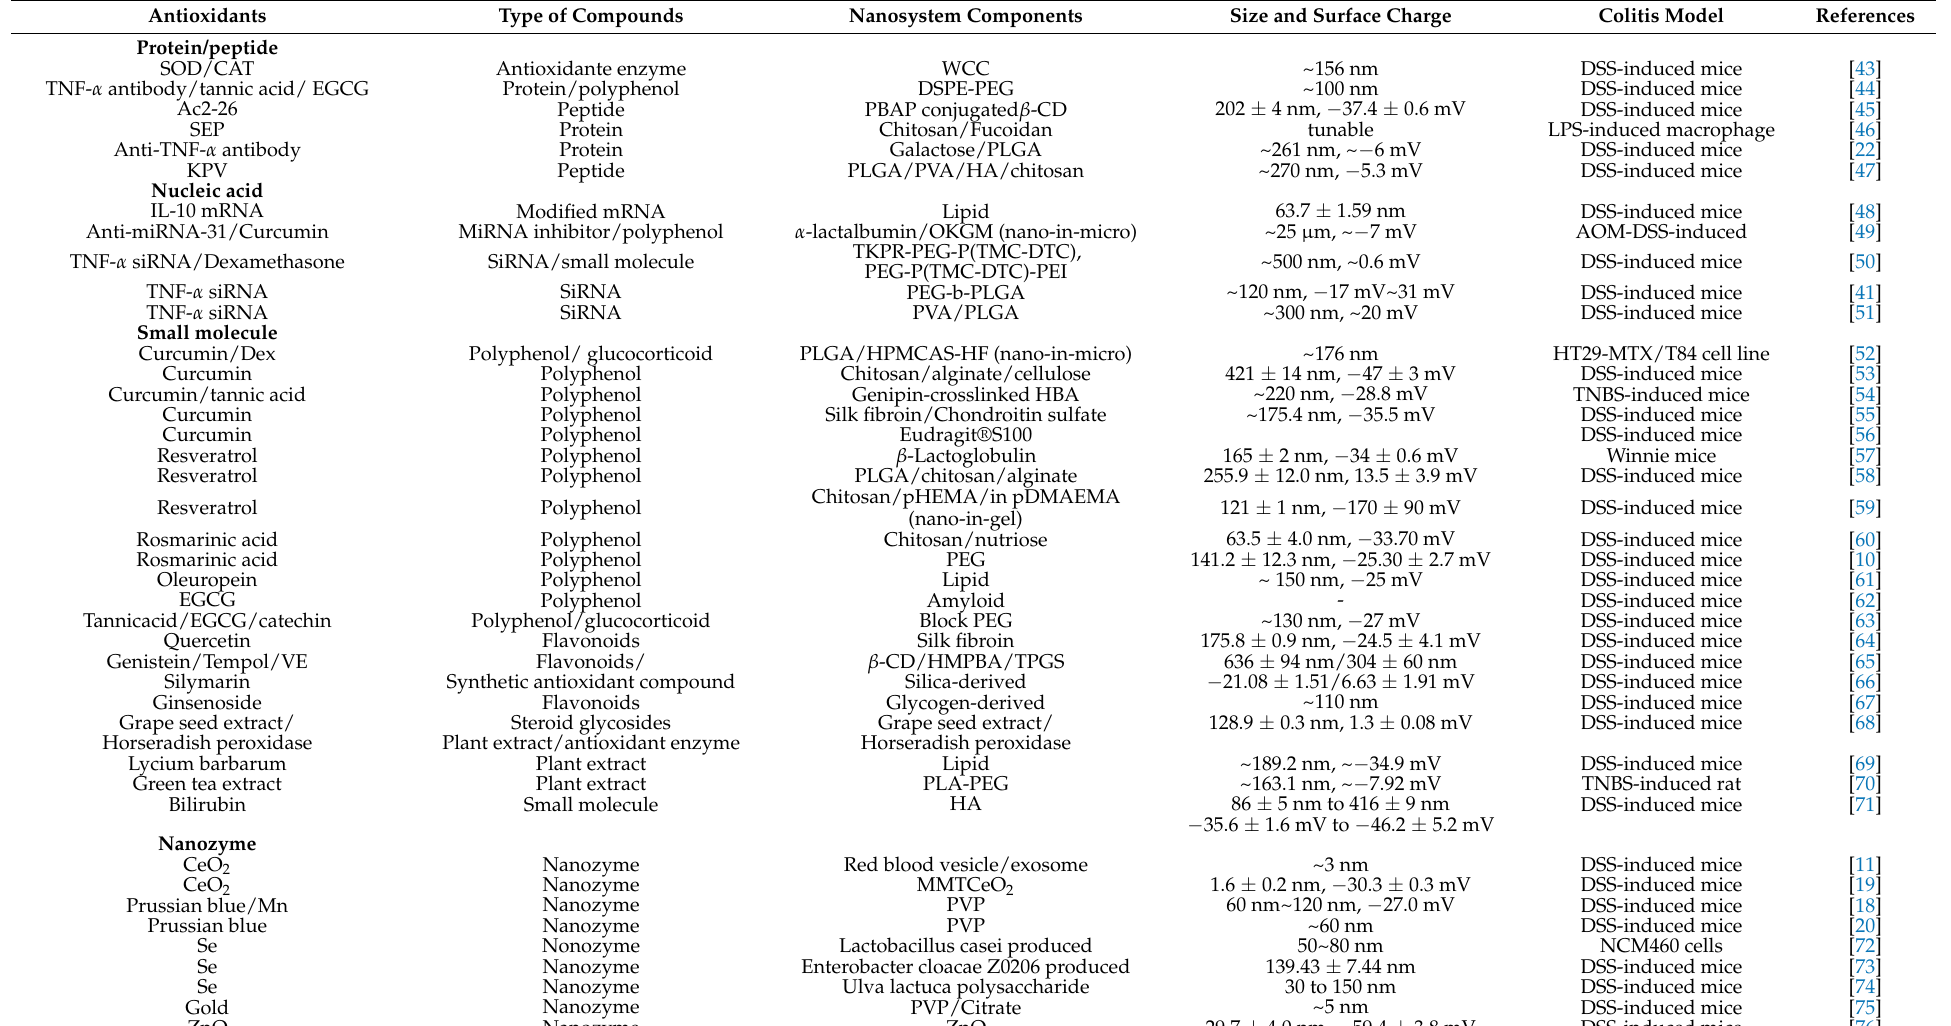
Table 1. Examples of new innovative antioxidant nanotherapeutic approaches against IBD within the last 5